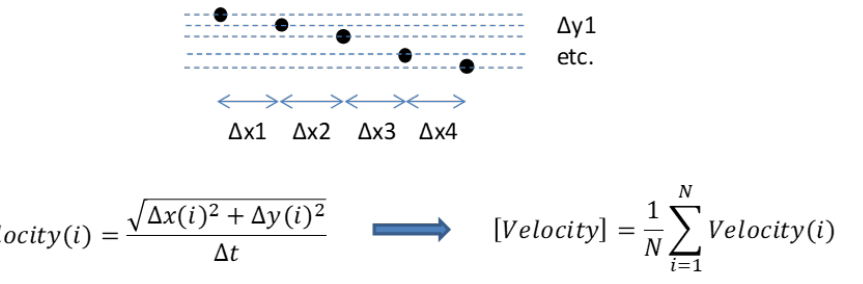
Figure 3. The general algorithm for the calculation of the particle velocity by using recordings of particle movement in the channel. To calculate the average velocity of each particle, 5 to 30 positions were tracked per particle.